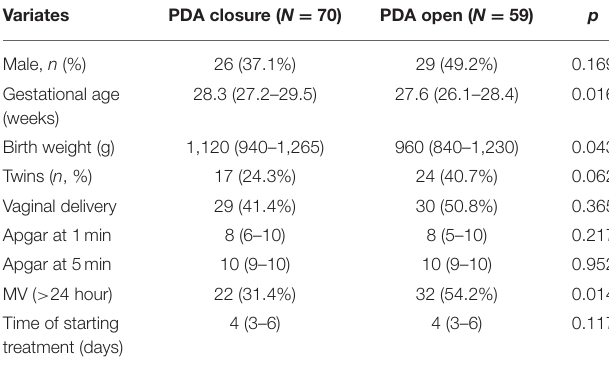
PDA closure after Ibuprofen treatment.